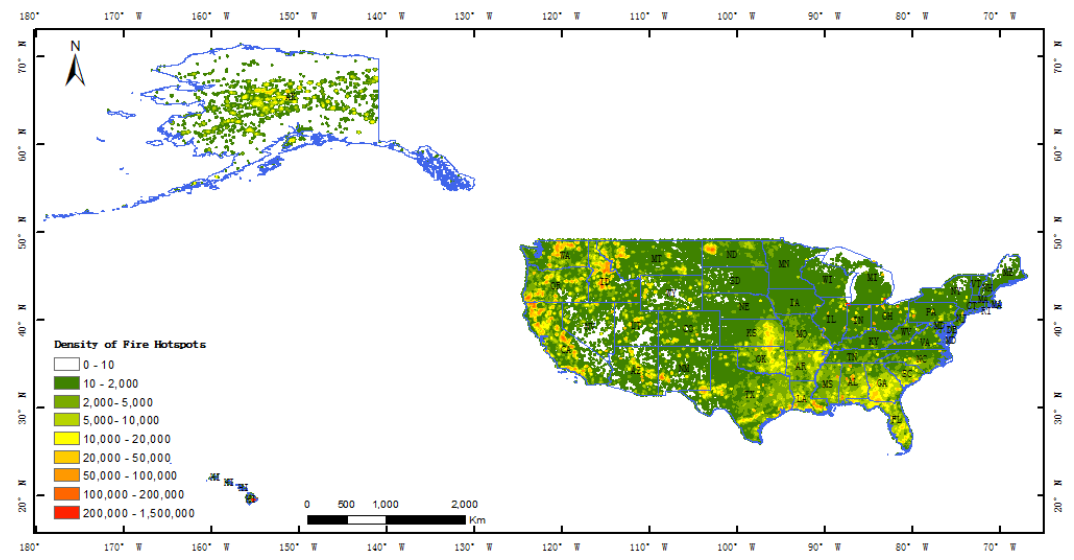
Figure 2. The density and spatial distribution of active fires in the United